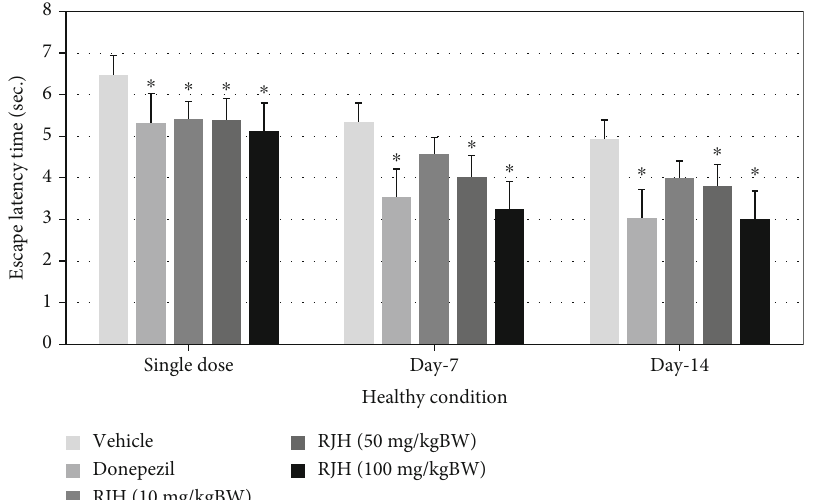
Figure 3: The e ff ect of RJH on escape latency time in healthy condition. Rats were treated with vehicle, donepezil, or RJH in various doses ranging from 10, 50, to 100 mg/kg BW via oral route for 14 days; then, their escape latency time was determined in the Morris water maze test. The test was performed within 30 minutes after the substance administration. Data are presented as mean ± SEM ( n = 8/group ). ∗ p < 0 : 05 compared with the vehicle-treated